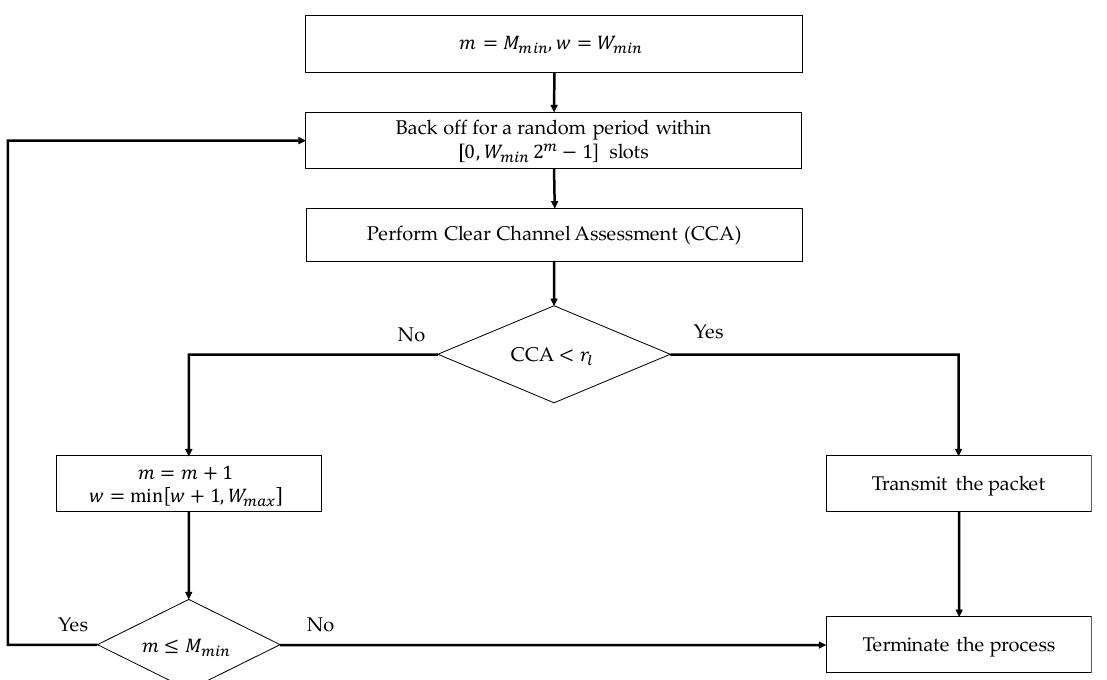
Figure 1. Flow chart of the IEEE 802.15.7 CSMA-CA protocol.